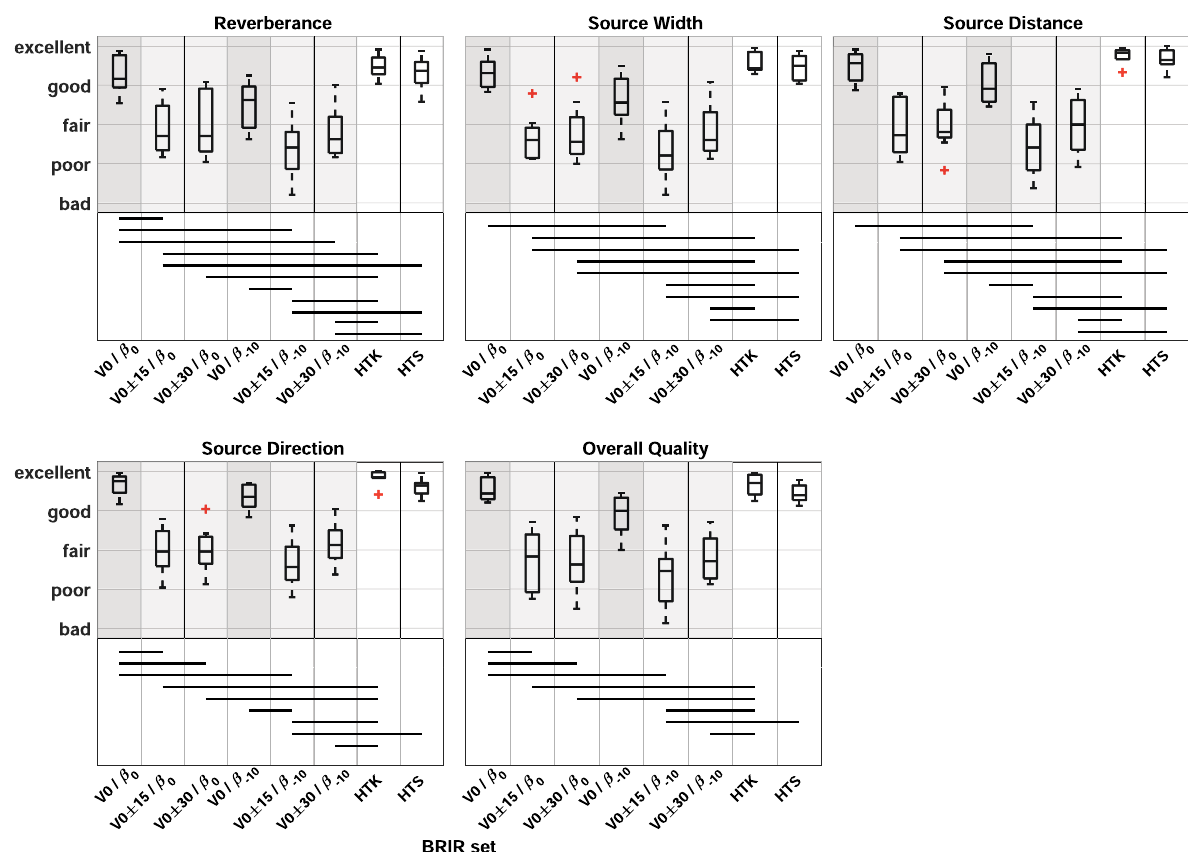
Figure 8. (Experiment 1) Averaged ratings over four source positions for different BRIR sets and perceptual attributes. Signi fi cant different ratings are marked with horizontal lines ( p <